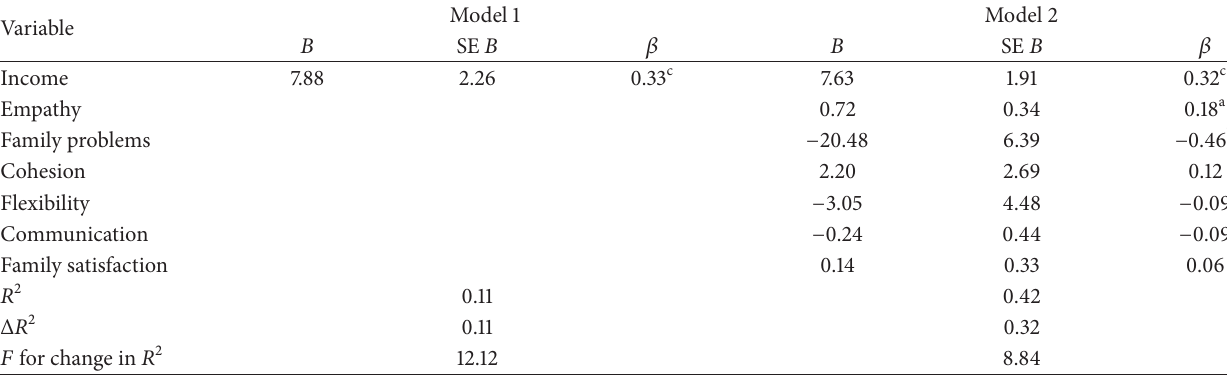
Table 3: Hierarchical multiple regression associations between caregiver income, family dynamics factors, and resilience. Variable